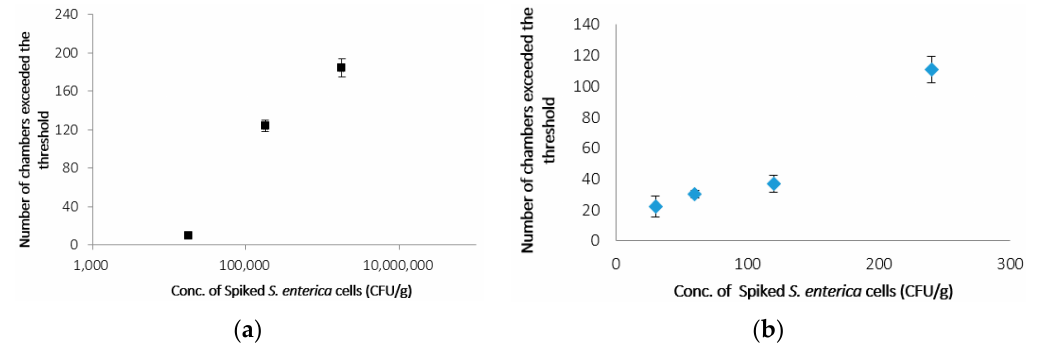
Figure 5. ( a ) number of microchambers exceeded the threshold after cultivation for 4 h; ( b ) number of microchambers exceeded the threshold after cultivation for 8 h. Error bars indicate standard deviation (SD) ( n = 3).